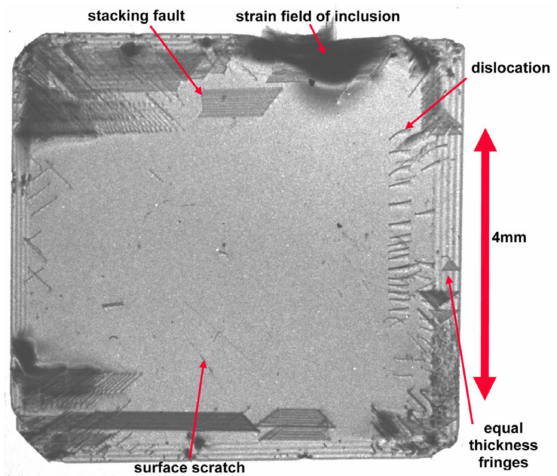
Figure 7. The white-beam topographic image of an HPHT grown type IIa single crystal (100) oriented plate from the paper of Burns et al. (ref. [41]). The centre portion of the crystal has almost no dislocations, and few dislocations are seen only on the side and stacking faults at the edges. The size of the plate is about 4 mm × 4 mm, and the FWHM of the rocking curve is approximately 1 arc sec. The image is taken from ref. [41]: Burns, R.C.; Chumakov, A.I.; Connel, S.H.; Dube, D.; Godfried,